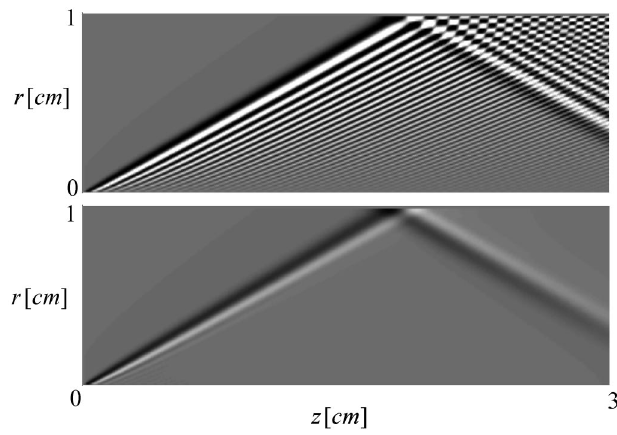
FIG. 12. Cherenkov radiation emitted by an electron traveling through a dielectric pipe at twice the local speed of light. The upper figure presents the result obtained without damping. The bottom figure outlines the result for the scheme with the damping parameter d (cid:5) 0 : 125